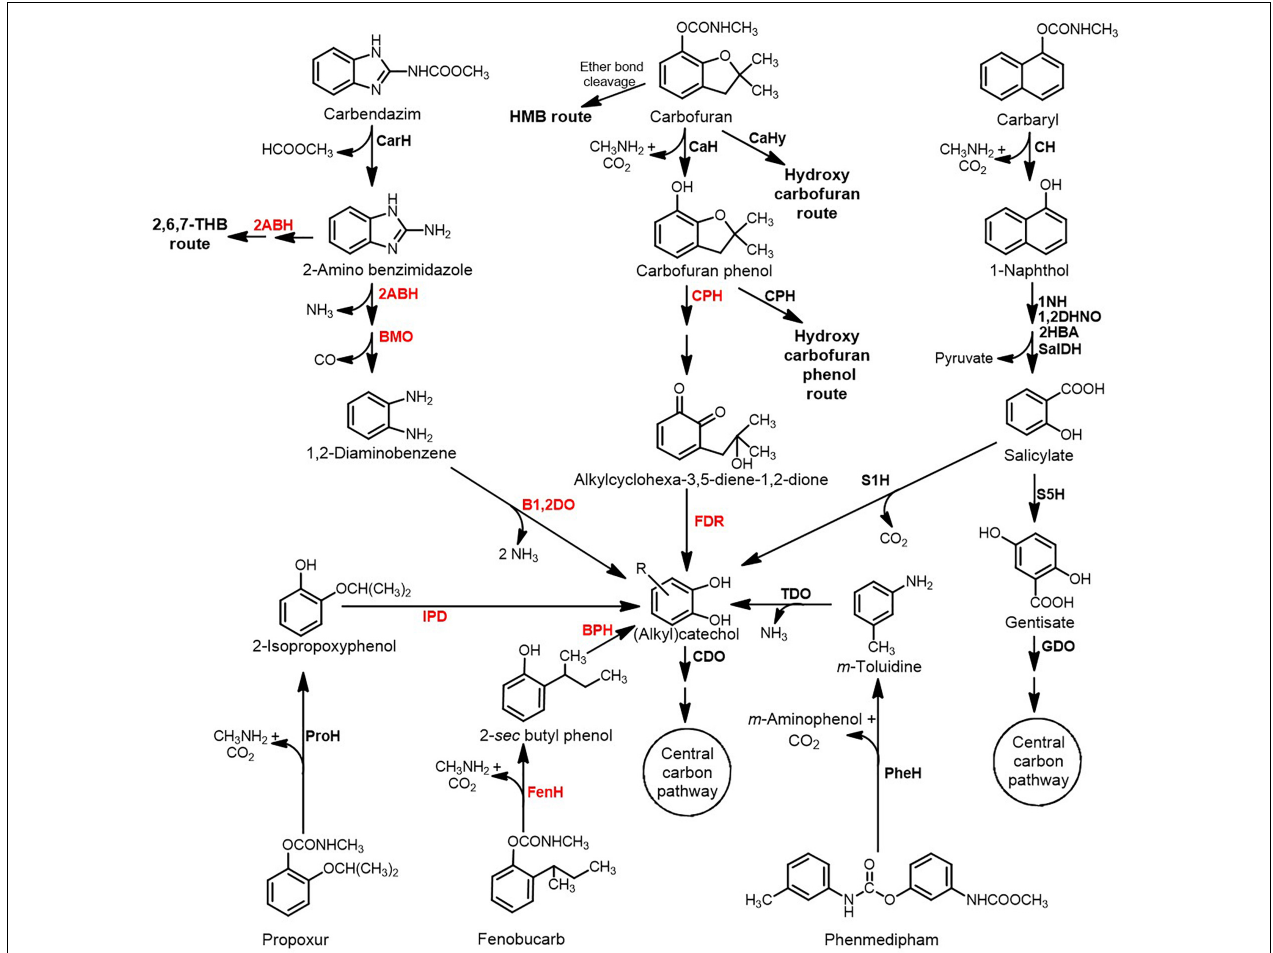
FIGURE 3 | Metabolic pathways for the degradation of aromatic ring-based carbamate pesticides. Various key enzymes involved are depicted in bold: CarH, Carbendazim hydrolase; 2ABH, 2-Aminobenzimidazole hydroxylase; BMO, Benzimidazolone monooxygenase; B1,2DO, Benzoate-1,2-dioxygenase; CaH, Carbofuran hydrolase; CaHy, Carbofuran hydroxylase; CPH, Carbofuran phenol hydroxylase; FDR, Flavin-dependent reductase; CH, Carbaryl hydrolase; 1NH, 1-Naphthol 2-hydroxylase; 1,2DHNO, 1,2-Dihydroxynaphthalene dioxygenase; 2HBA, 2-Hydroxybenzalpyruvate aldolase; SalDH, Salicylaldehyde dehydrogenase; S1H, Salicylate1-hydroxylase; S5H, Salicylate 5-hydroxylase; GDO, Gentisate dioxygenase; ProH, Propoxur hydrolase; IPD, Isopropoxyphenol O -dealkylase; FenH, Fenobucarb hydrolase; BPH, 2- sec Butylphenol hydroxylase; PheH, Phenmedipham hydrolase; TDO, Toluidine dioxygenase; and CDO, Catechol dioxygenase. Enzymes in the red font indicate the activity was reported at the biotransformation or annotation at the genome level; while those in black font indicates enzyme activities measured from the cell-free extract and some of them have been purified and characterised. HMB indicates 2-hydroxy-3-(3-methylpropan-2-ol) benzene- N